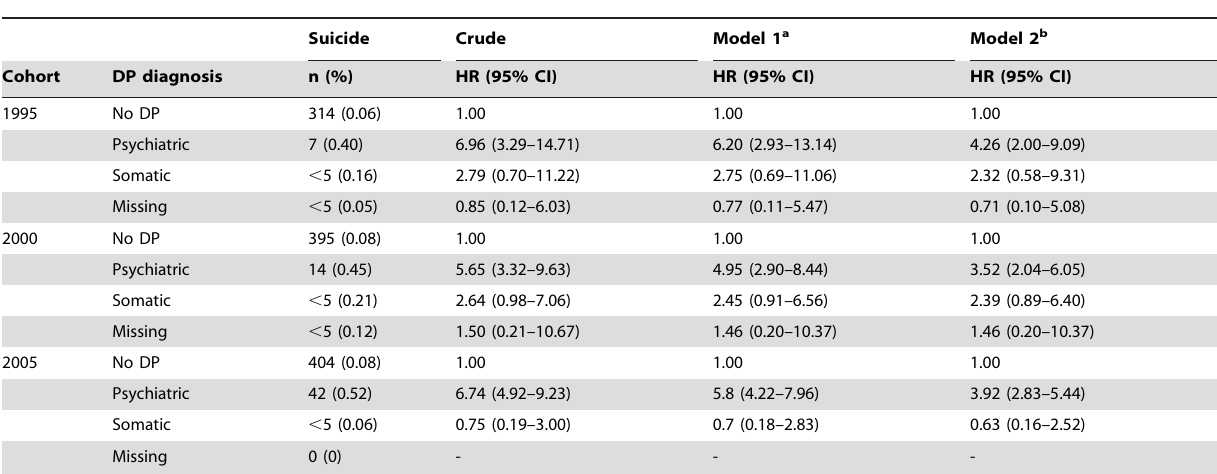
Table 7. Hazard ratios (HR) and 95% confidence intervals (CI) for suicide during a five-year follow-up of young adults with disability pension (DP) due to psychiatric , somatic, or missing diagnoses in 1995, 2000, and 2005, respectively 1